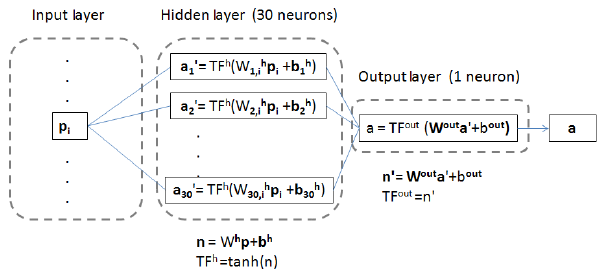
Figure 3. Schematic representation of the artificial neural network used in this study, where p i = p i ( N di , VIS i , FCS i , RH i , Temp i ) with i = 1 ,...,N , with N being the total number of observations and a = ANN